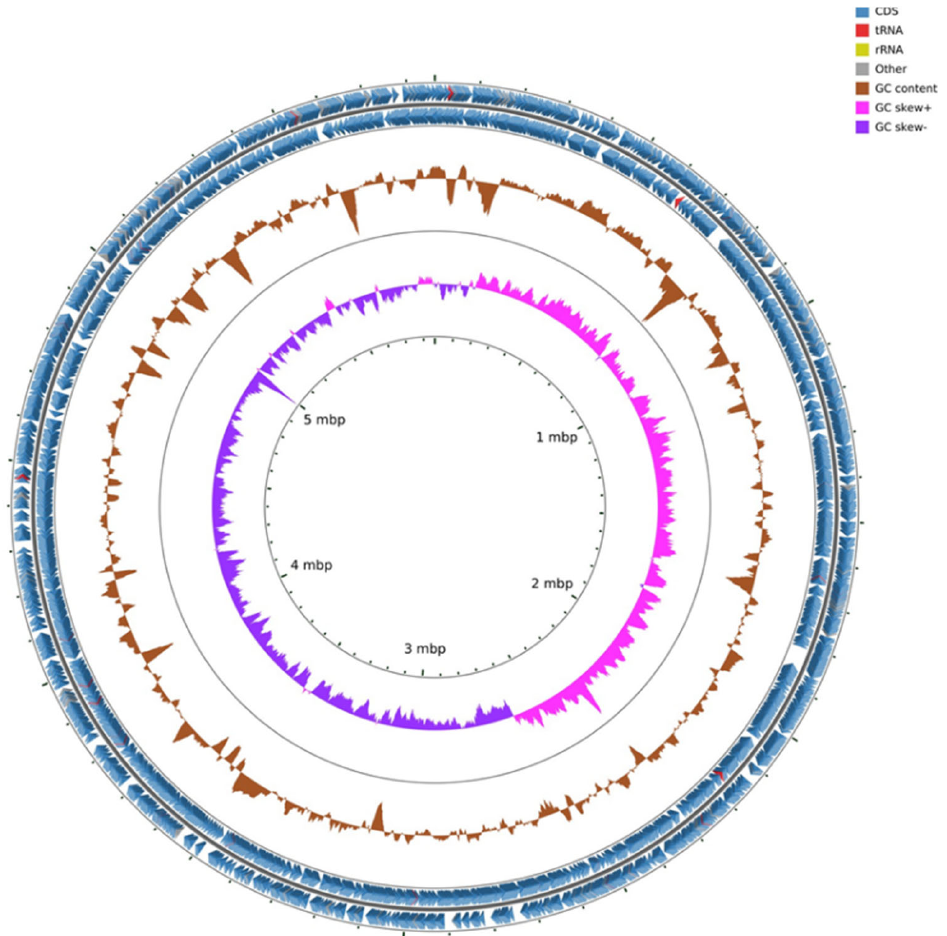
Figure 1. Genome map of Pseudomonas ST1 strain with coding sequence (CDS), transfer RNA (tRNA), ribosomal RNA (rRNA), GC content, and inner cycle scale.